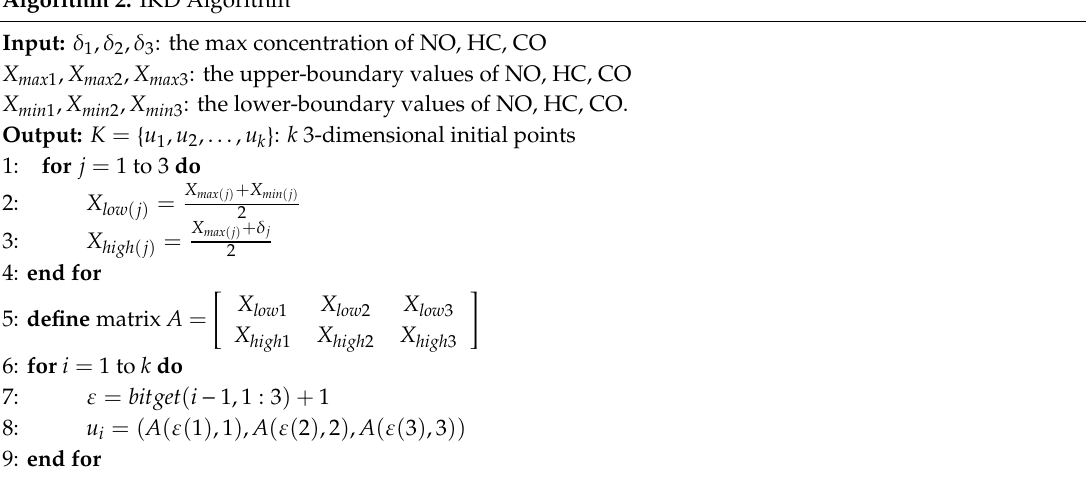
Algorithm 2. IKD